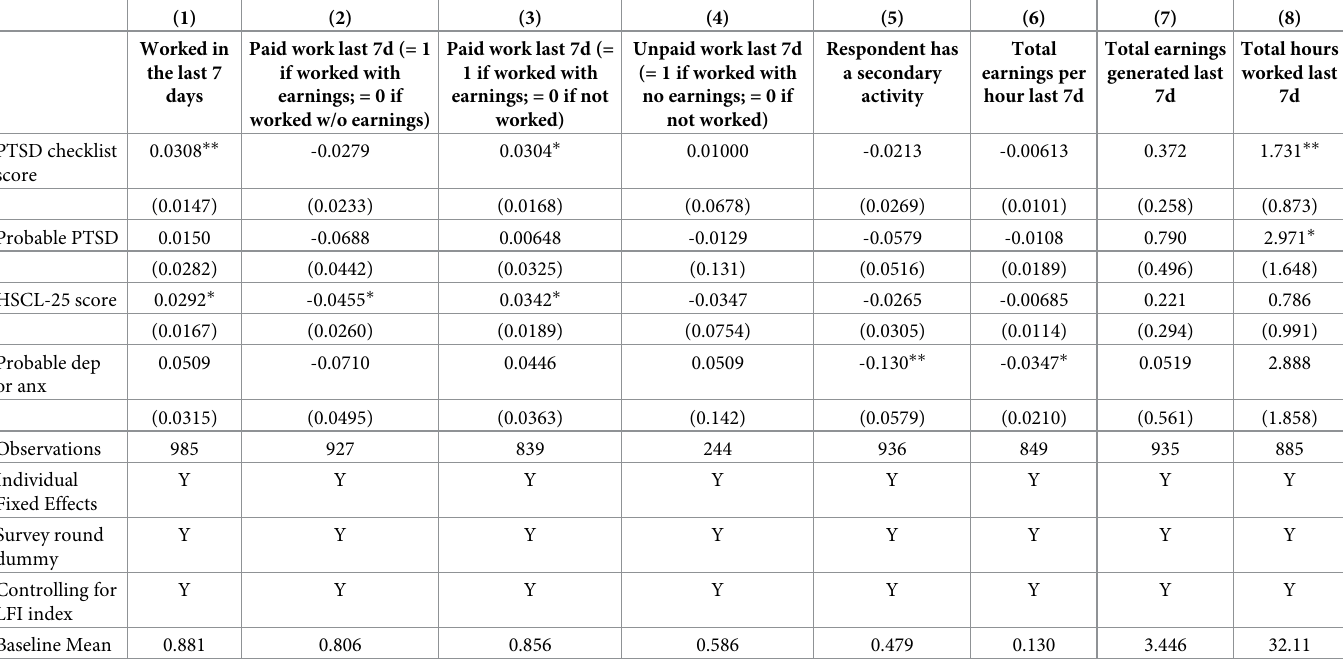
Table 8. Panel regression of women’s work on mental health outcomes, controlling for LFI